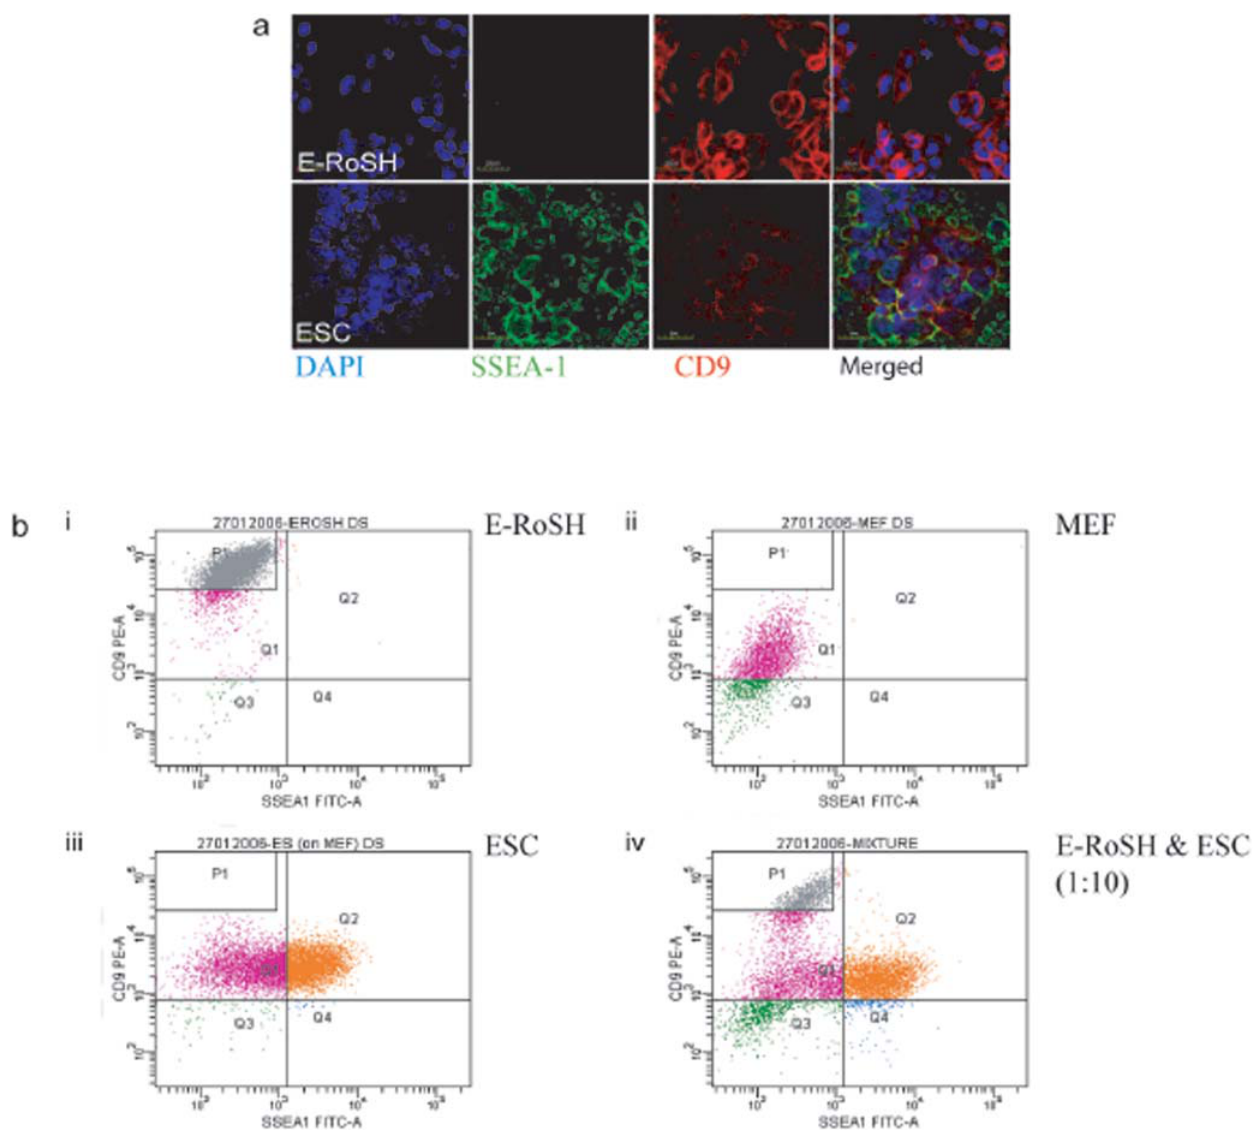
Figure 4. Identifying selectable surface antigens for the isolation of putative RoSH-like cells from differentiating ESCs. a) Confocal microscopy of E- RoSH2.1 cells (top) and E14 ESCs (bottom) . The cells were counterstained with DAPI, a nuclear stain after immunostaining for anti-SSE4-1 antibody conjugated with FITC and anti-CD9 antibody conjugated with PE. b) FACS analysis of i) E-RoSH2.1 cells, ii) E14 ESCs, iii) murine embryonic fibroblast (MEF) and iv) 10:1 mixture of E14 ESCs and E-RoSH2.1 cells. The cells were labelled with anti-CD9 antibody conjugated with PE and anti-SSE4-1 antibody conjugated with FITC, and analyzed on a FACS Aria using FACS Diva software (BD Biosciences Pharmingen, San Diego, CA).